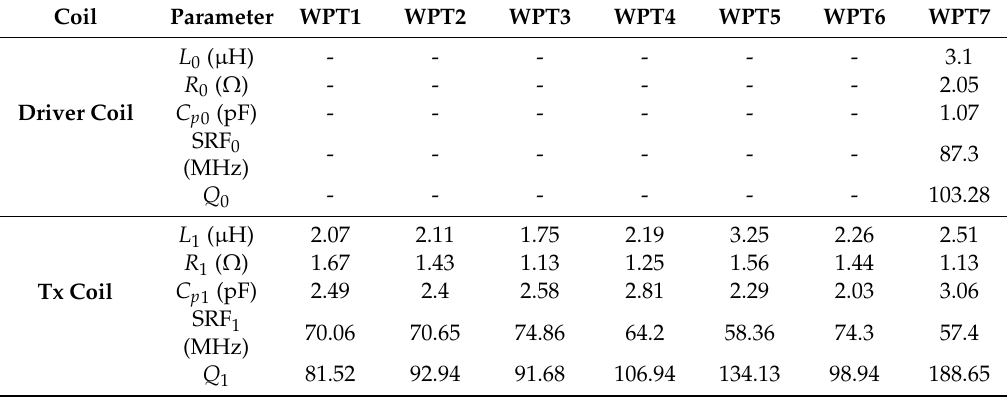
Table 3. Results of high-frequency structure simulator (HFSS)